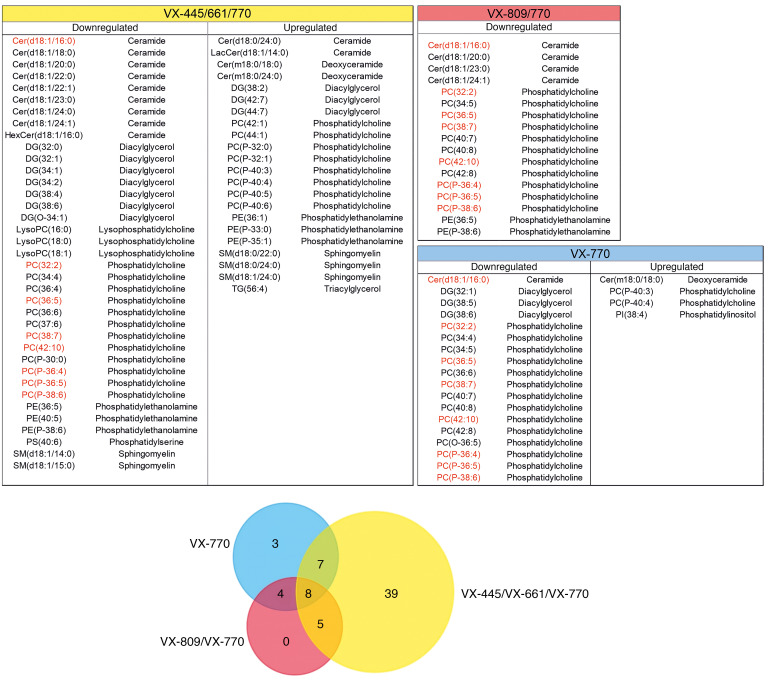
Significantly upregulated and downregulated lipids observed in the 3 VX-770 groups compared with control and corresponding Venn diagram of overlap.The 8 lipids indicated in red are at the intersection of the 3 groups. (FDR-adjusted P = 0.05, fold change >1.5.